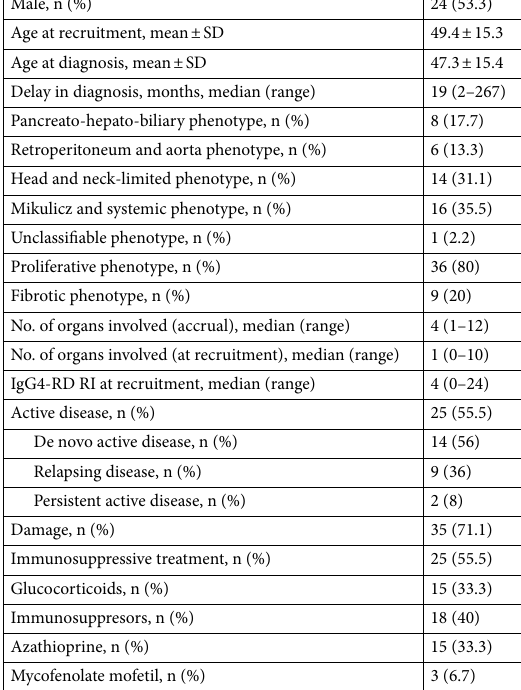
Table 1. Clinical characteristics of 45 IgG4-related disease patients. IgG4-RD RI IgG4-related disease responder